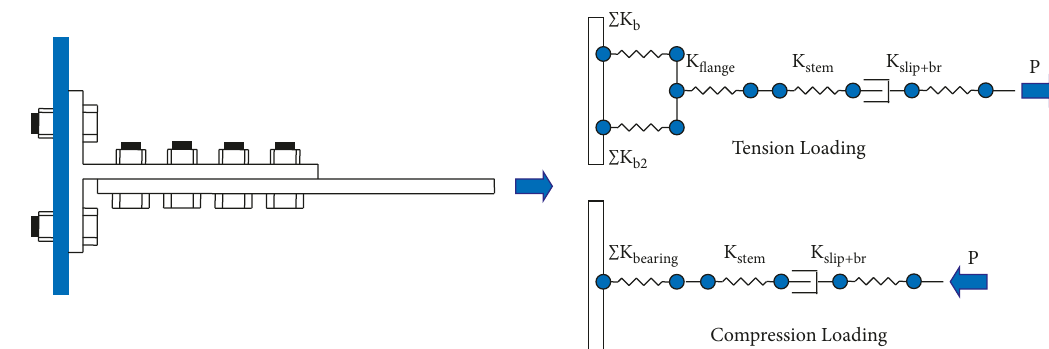
Figure 1: Hu calculation model.